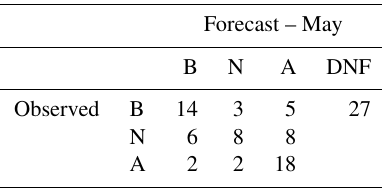
Table 4. Stat-P&S model categorical streamflow results: observed vs.